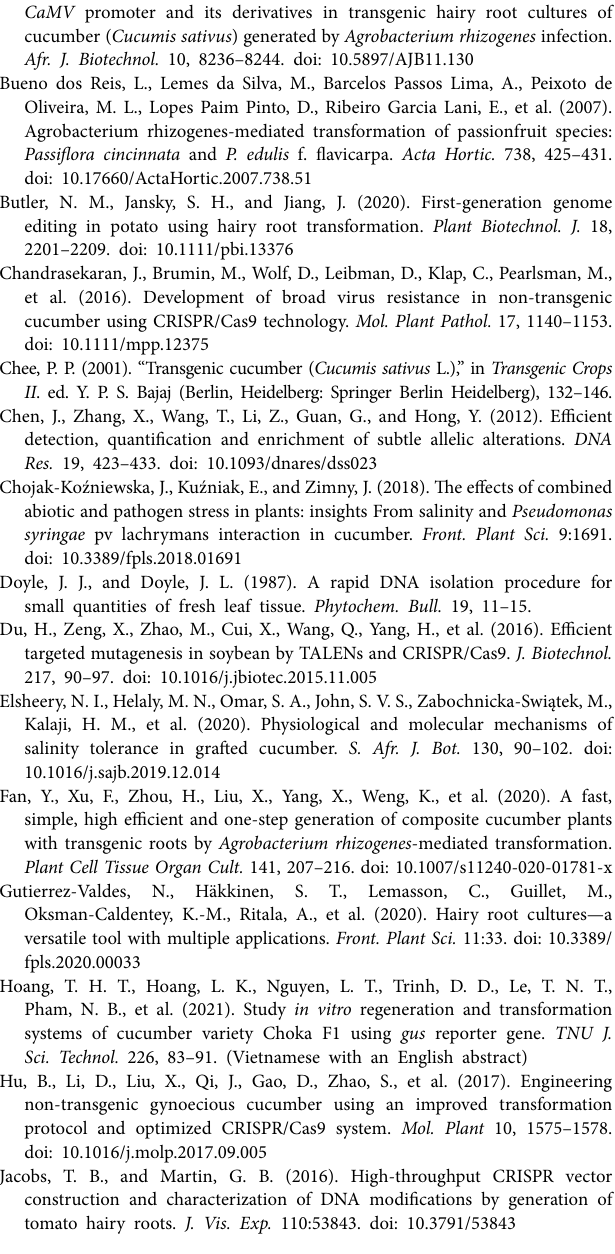
Supplementary Figure S1 | Cucumber hairy root induction by Rhizobium rhizogenes strain K599 and ATCC 15834. The photos were captured at 10 days after co-cultivation. Supplementary Figure S2 | GUS histochemical analysis of the herbicide resistant hairy roots. WT: non-transgenic hairy roots grown on the PPT free medium; 1–14: Hairy root lines survived and developed on the selection medium with PPT. Supplementary Figure S3 | Distribution of root hair phenotypes of tested cucumber hairy roots.